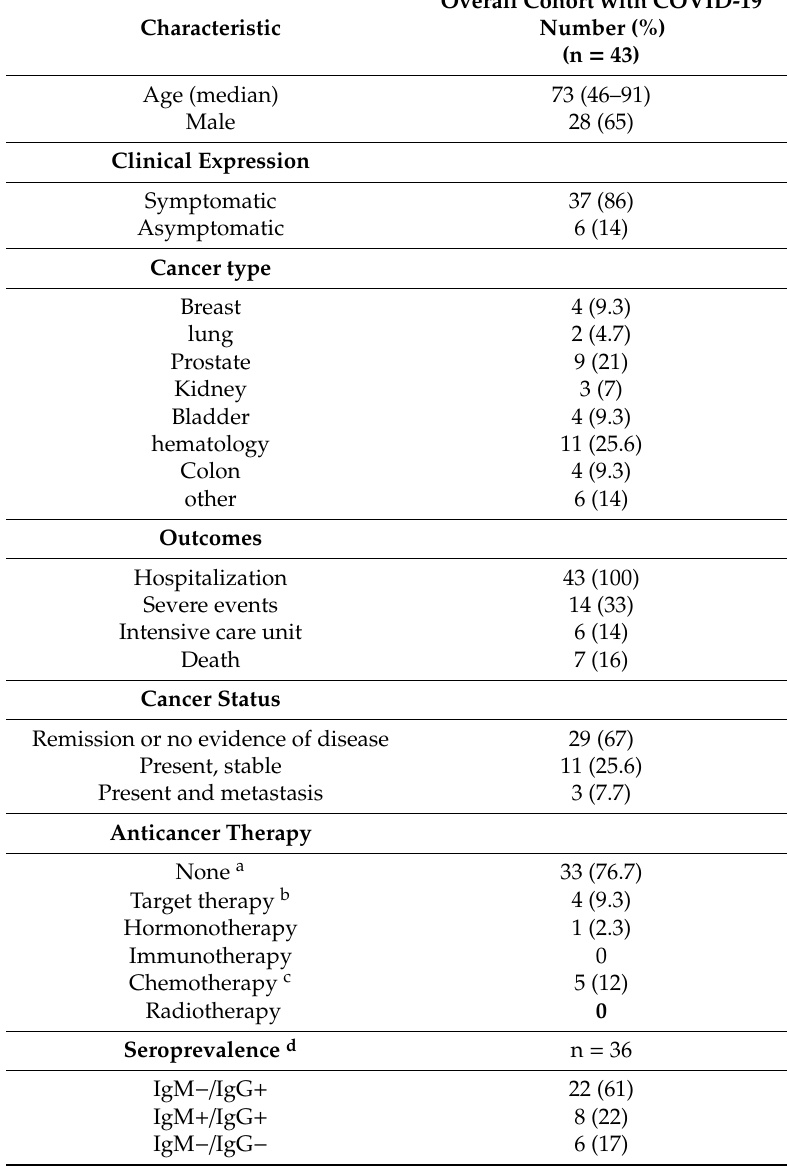
Table 1. Demographic, clinical characteristic, and seroprevalence of COVID-19 infected cancer patients. Cohort